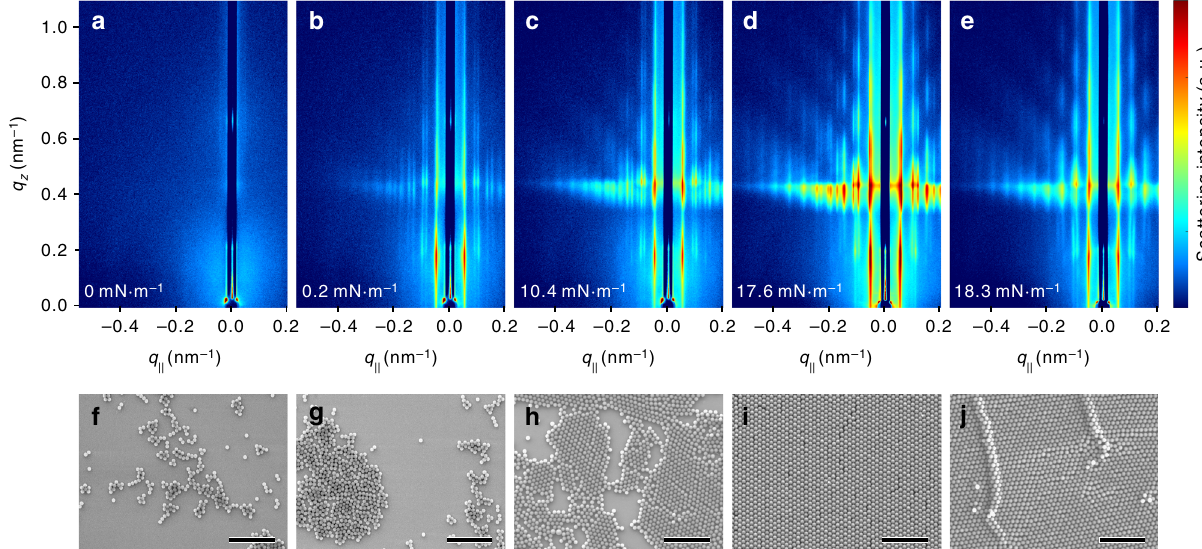
Fig. 2 In situ GISAXS and ex situ SEM measurements. a – e The in situ GISAXS patterns recorded during the self-assembly of PNSs at the air/water interface of the LB trough at the surface pressures of 0, 0.2, 10.4, 17.6, 18.3 mN m − 1 and the corresponding areas per particle are 3.68 × 10 − 2 , 2.82 × 10 − 2 , 2.30 × 10 − 2 , 2.13 × 10 − 2 , and 1.99 × 10 − 2 μ m 2 , respectively (marked as diamonds in Fig. 1c). f – j The ex situ SEM images of the dried PNSs on silicon substrates taken from the LB trough at the same assembling stages as the in situ GISAXS measurements (all the scale bars are 1.5 μ